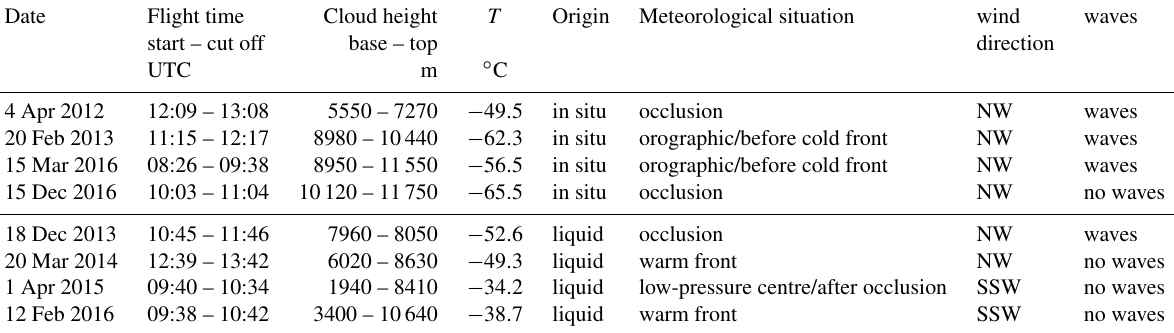
Table 1. List of measurement days, launch and cut-off times, cloud height, mean temperature, cloud origins, and meteorological situations. Date Flight time Cloud height T Origin Meteorological situation wind waves start – cut off base – top direction UTC m ◦ C 4 Apr 2012 12:09 – 13:08 5550 – 7270 − 49 . 5 in situ occlusion NW waves 20 Feb 2013 8980 – 10440 − 62 . 3 in situ orographic/before cold front NW waves − 56 . 5 in situ orographic/before cold front NW waves 15 Dec 2016 − 65 . 5 in situ occlusion NW no waves occlusion NW waves warm front NW liquid low-pressure centre/after occlusion SSW − 38 . 7 liquid warm front